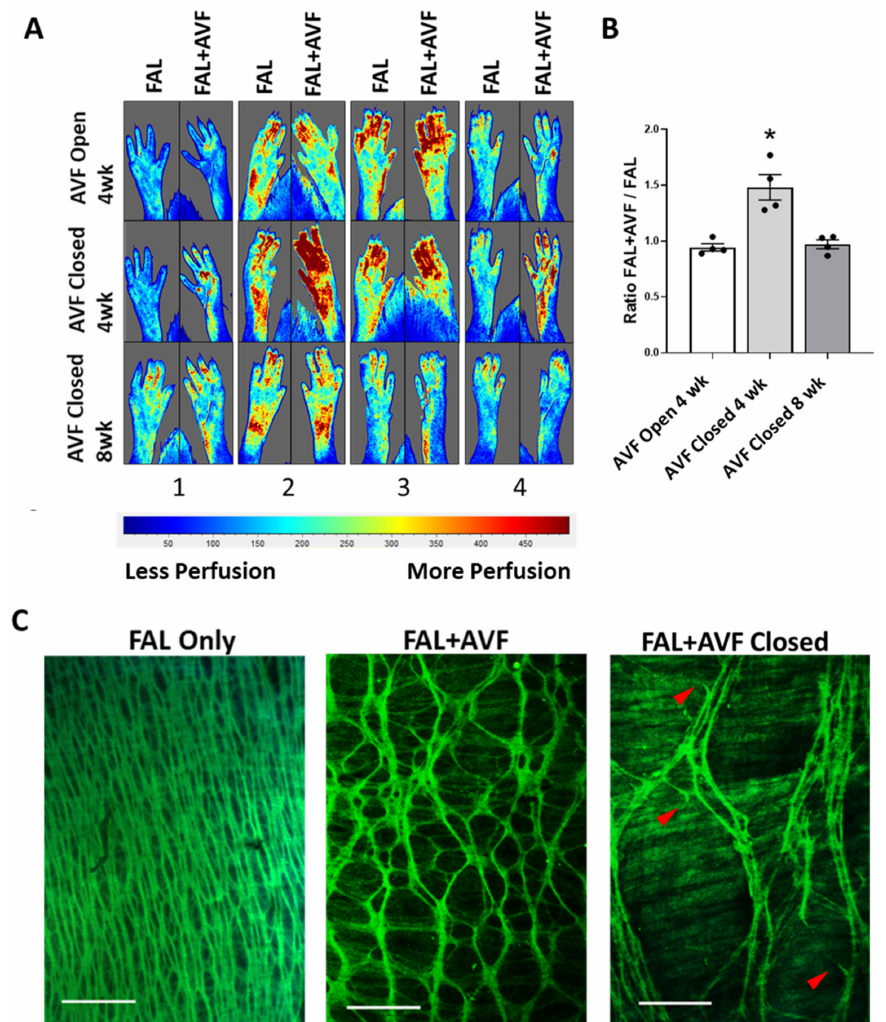
Figure 3. Late closure of the fistula. Subjects initially underwent FAL + AVF with a FAL only on the contralateral hindlimb. After 4 weeks of recovery, animals then underwent a second procedure whereby the arteries were re-exposed. When indicated, FAL + AVF closure was performed by placing a ligature on the distal CFA, preventing any additional direct arterial flow into the venous system. ( A ) Laser scatter contrast images (LSCI) show hindlimbs before and immediately after AVF closure at 4 weeks, then again at 8 weeks. ( B ) Perfusion was essentially normalized between the two limbs at 4 weeks and increased immediately after closure of FAL + AVF ( n = 4 animals, * denotes p = 0.002 when compared to other groups, One-way ANOVA with Tukey’s test), and notably re-normalized to the FAL hindlimb after another 4 weeks. ( C ) Sample projections of IEL from rat PFAs after a total of 8 weeks. Images demonstrate that IEL structure becomes more dispersed with apparent elastic fiber breakage (red arrowheads) and longitudinal consolidation of elastic cords after AVF closure is performed. Image acquired with Olympus FV1000MPE utilizing 830 nm laser. Bar = 50 µ m. n = 4 vessels imaged per